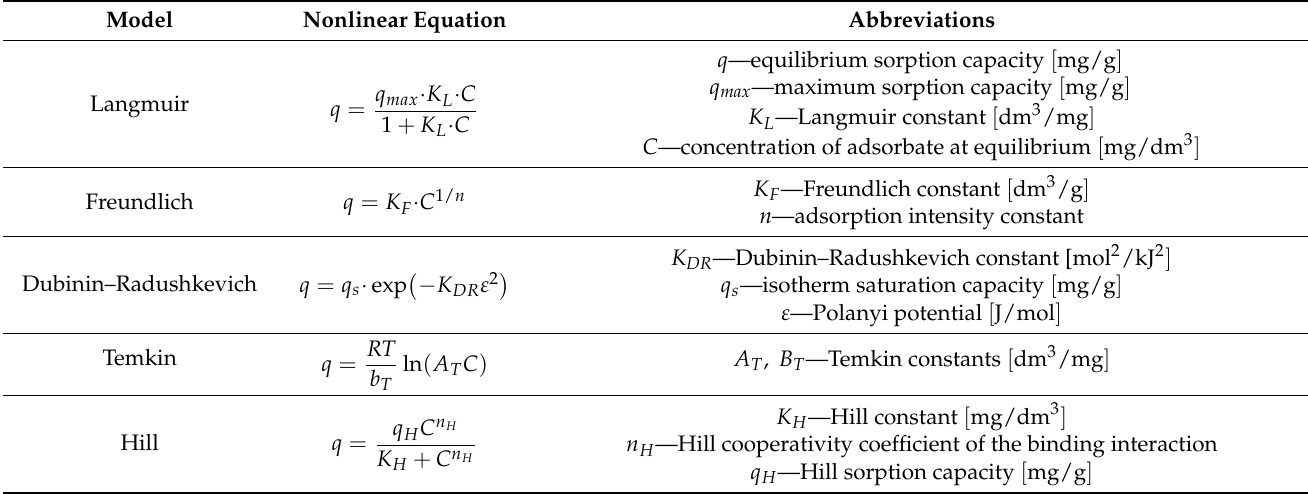
Table 1. Equations and parameters of isotherm